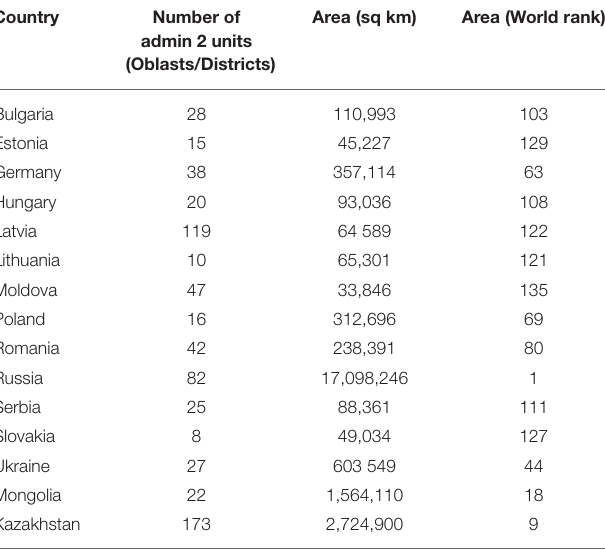
TABLE 3 | Comparison of number of oblasts/districts, and country extension (area and world rank) between Kazakhstan and ASF infected countries in Eastern Europe and central